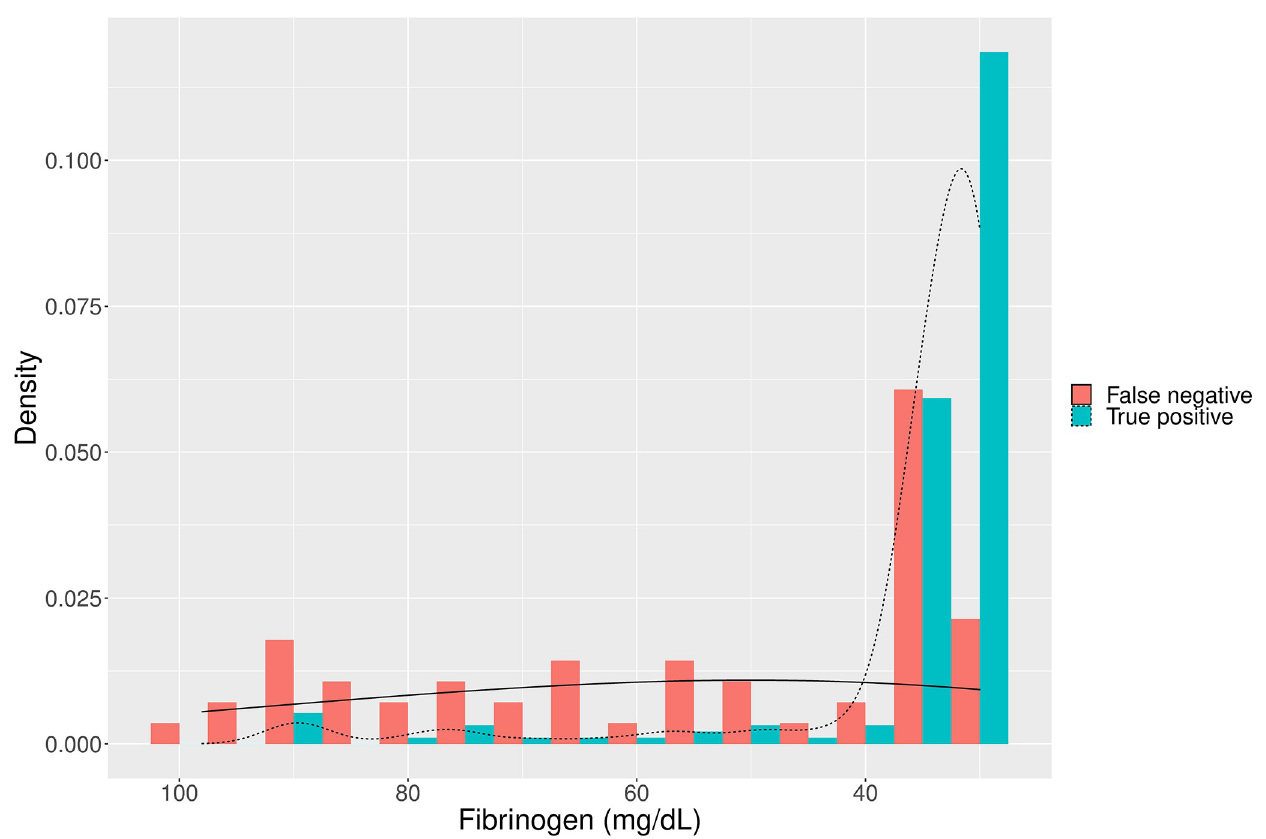
Fig 7. A density plot displaying the distribution of false negative and true positive 20WBCT results using a reference test of